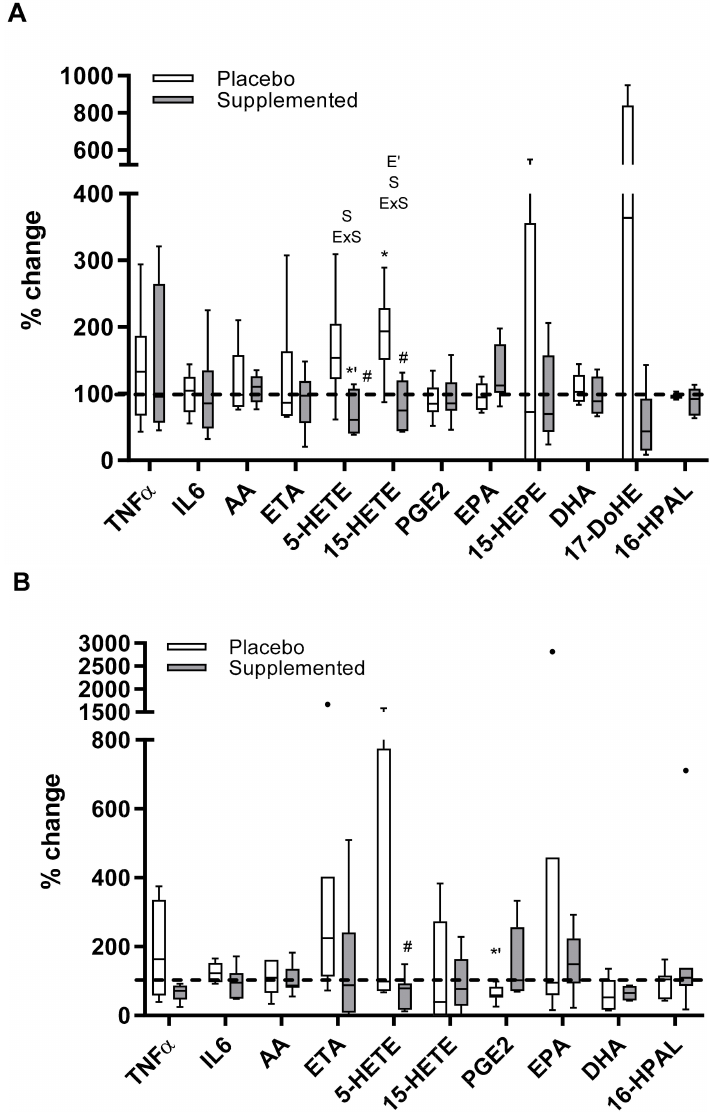
Figure 2. E ff ect of exercise and nitrate supplementation on the production of cytokines, fatty acids and oxylipins by PBMCs and neutrophils. Results represent the % change of Post-exercise production with respect to Pre-exercise production (100%, dashed line). Results are shown as median with interquartile range and outliers ( • ). Normality test: Shapiro–Wilk. ( A ) Peripheral blood mononuclear cells (PBMCs); AA, 5-HETE, 15-HETE, DHA, 16-HPAL, normal distribution; remaining parameters, non-normal